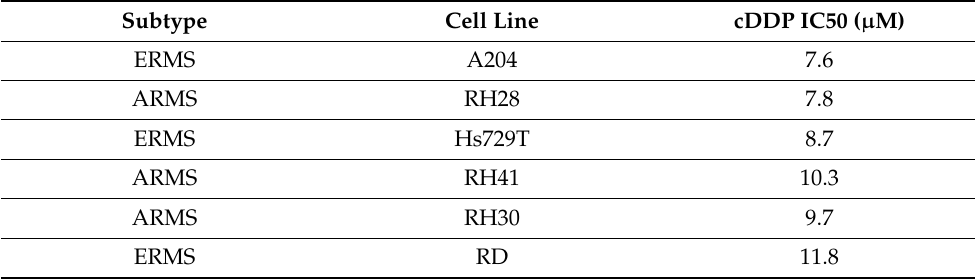
Table 4. Cisplatin IC50 in RMS cell